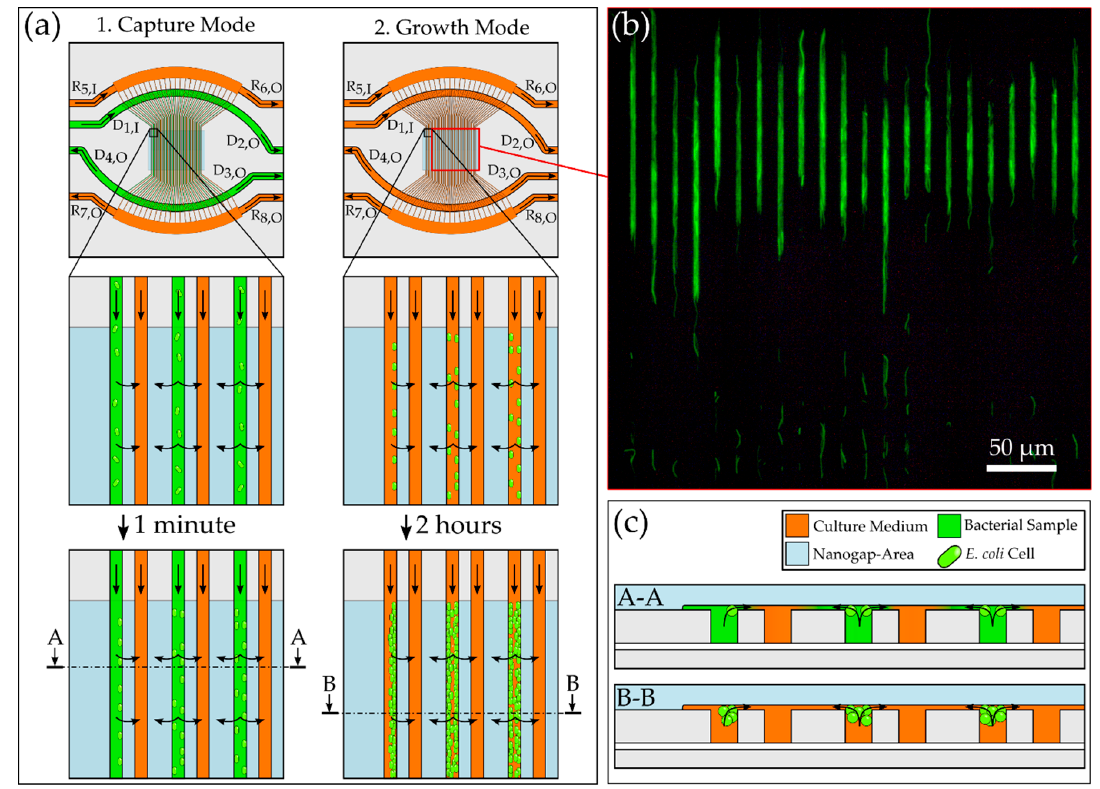
Figure 5. ( a ) Schematic illustrating the flows from the vials D 1–4 and R 5–8 in capture mode to load bacteria into the grating and the growth mode in order to observe the growth behavior of immobilized Escherichia coli . ( b ) Fluorescent image of bacteria immobilized at the nanogap area and incubated for 240 min. ( c ) Schematic cross-sectional view of the nanogap area.